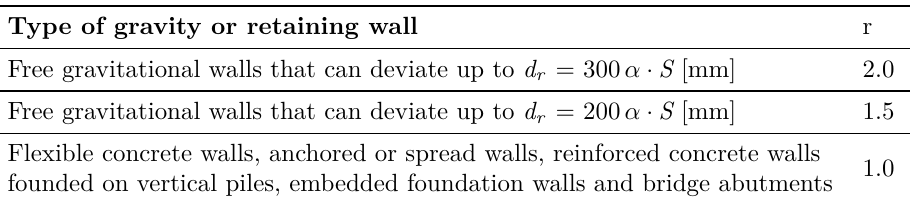
Table 1. Values of the coefficient r for the calculation of the horizontal seismic coefficient ( α is the ratio of the design acceleration a d for the foundation soil type A to the gravitational acceleration g , S is the subsoil coefficient defined in Eurocode 1998-1)